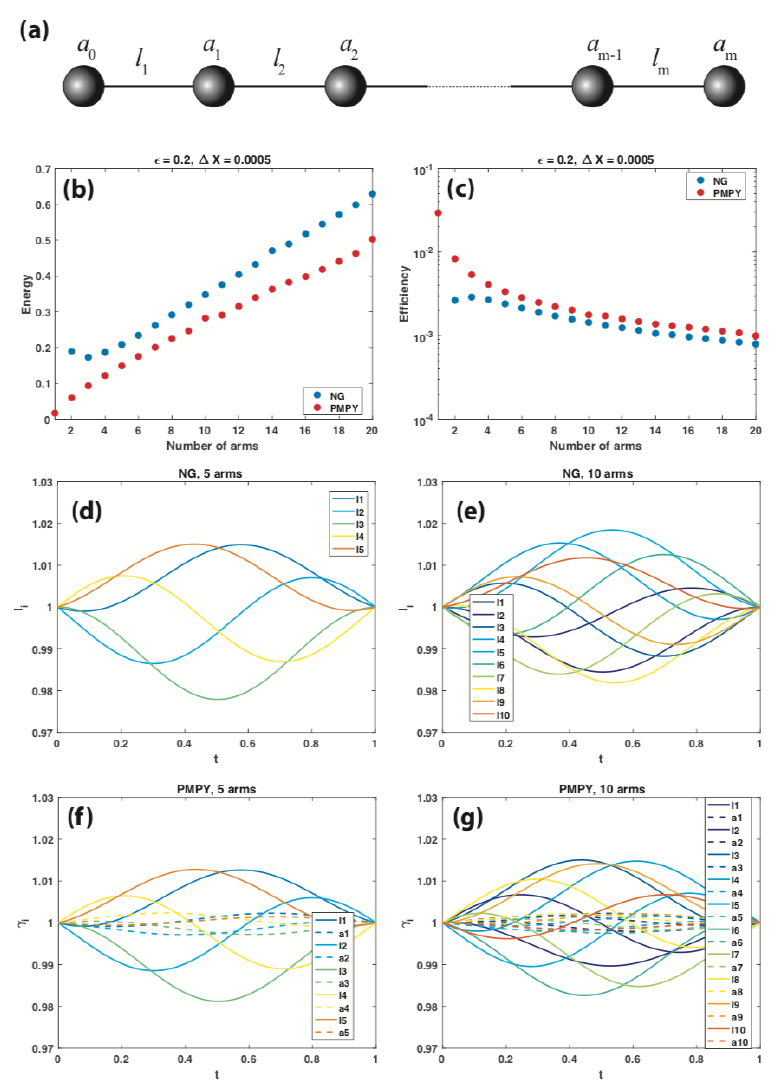
Figure 3. ( m + 1 ) -linked-sphere NG-type or PMPY-type of swimmers. ( a ) Cartoon illustration of the swimmer, which consists of m + 1 spheres and m linking-arms. ( b ) Energy dissipation of optimal strokes E ( γ ) and ( c ) efficiency Eff of NG (blue dots) and PMPY (red dots) swimmers with m linking-arms. ( d , e ) The γ -path of the optimal stroke γ of a NG swimmer with 5 and 10 linked arms, respectively, where γ = ( l 1 , l 2 , · · · , l m ) T . ( f , g ) The γ -path of the optimal stroke γ of a PMPY swimmer with 5 and 10 linked arms, respectively, where γ = ( l 1 , l 2 , · · · , l m , a 1 , a 2 , · · · , a m ) T , where the solid lines give the l i -trajectories and dashed lines the a i -trajectories. ε = 0.2 and X = 5 × 10 − 4 in all